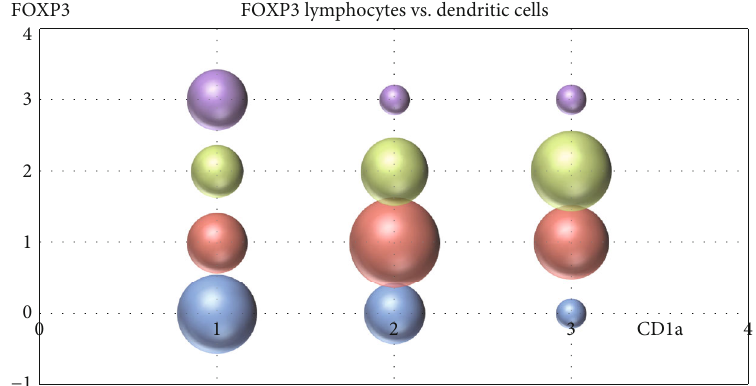
Figure 12: Correlation between the presence of intratumoral dendritic cells and FOXP3-positive lymph